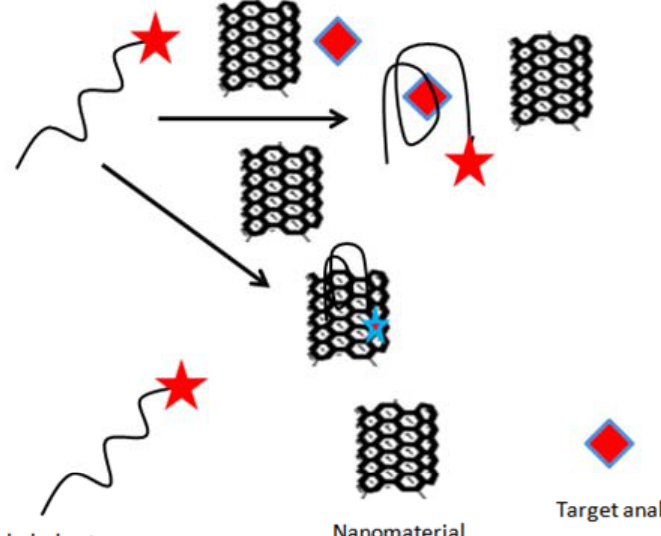
Figure 2. Single-walled carbon nanotubes based quenching of free FAM-aptamer for selective determination of ochratoxin A